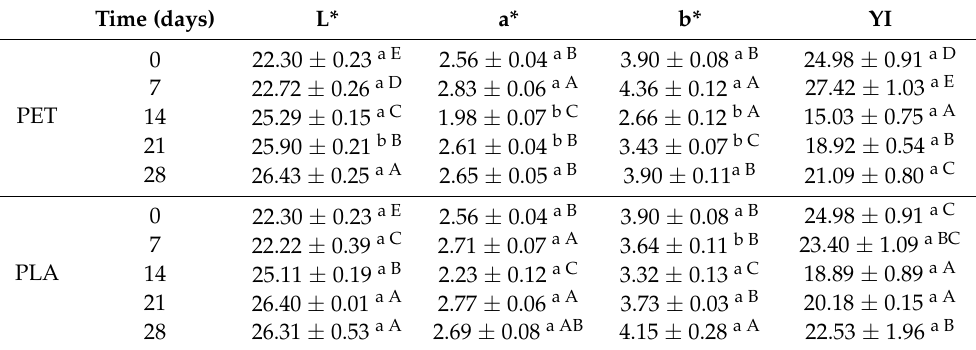
Table 3. Instrumental color parameters of HPP-treated apple juice during refrigerated storage at 6 ◦ C in PLA and PET bottles. L*: lightness, a*: redness-greenness, b*: yellowness-blueness, YI: yellowness index. Values are presented as mean ± standard deviation.